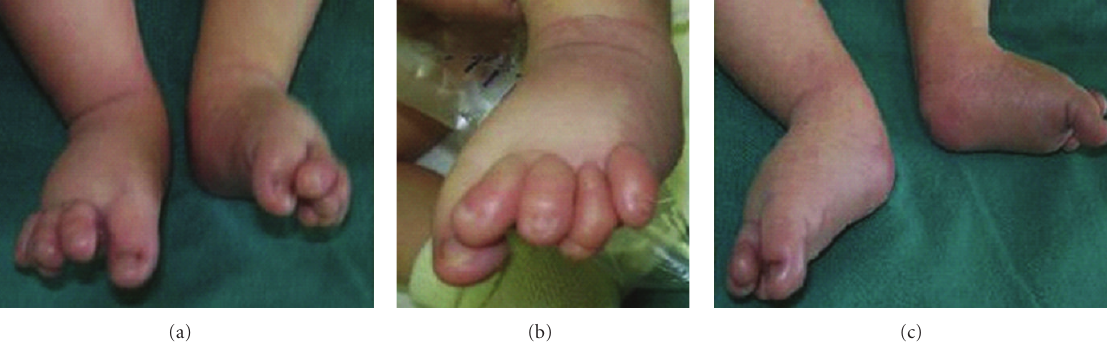
Figure 3: Right and left feet. Note swelling at dorsum with tibial clinodactyly of both second toes, hypoplastic nails, and tapering of second over hallux and third and fifth over fourth toes bilateral and symmetrically. Archives of Drs. de Le´on NE and Ben´ıtez DB. William Soler cardiocentre. With the consent of the parents.